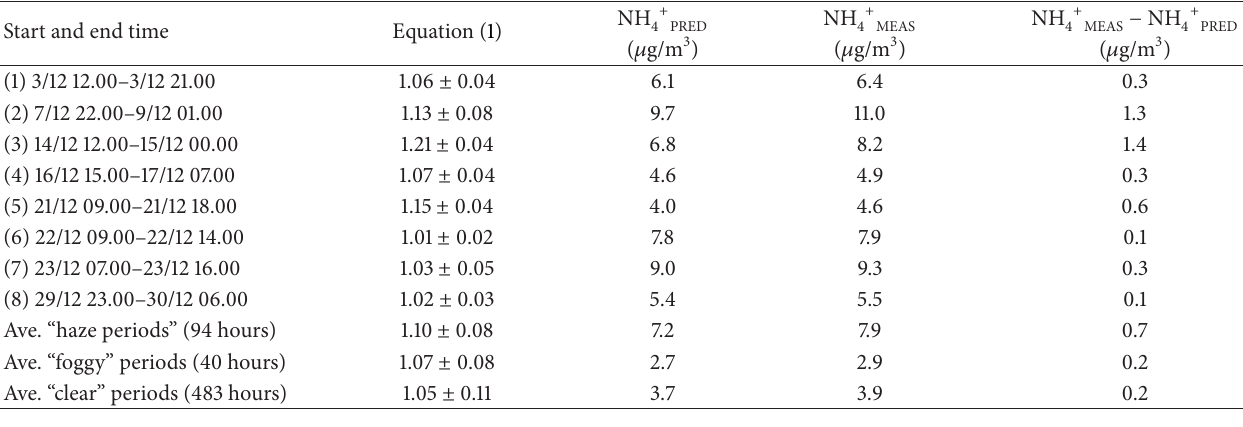
Table 3: Average values for the molar equivalent ratio of ammonium to the sum of sulfate and nitrate (1), [NH 4+ ] difference between the latter two during the haze, foggy, and clear weather periods.